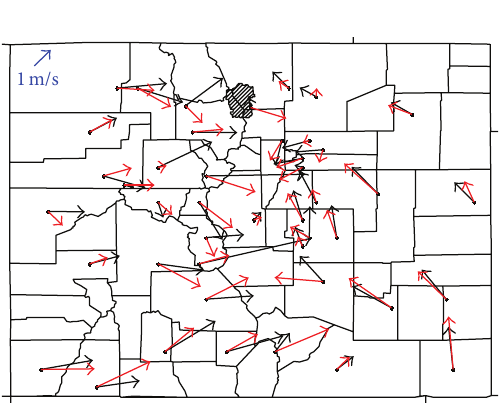
Figure 4: Mean observed (black) and modeled (red) wind vectors in Colorado for June–August 2009 at 3 :00 pm local time. Internal lines are county boundaries. The hatched area is Rocky Mountain National Park. Colorado is 450 by 610km, bounded by 37 and 41 degrees north latitude and by 109 and 102 degrees west